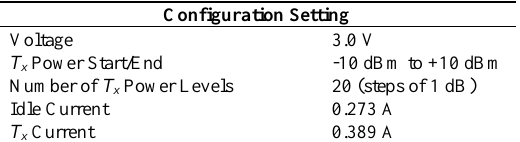
Table 2. The transmission power